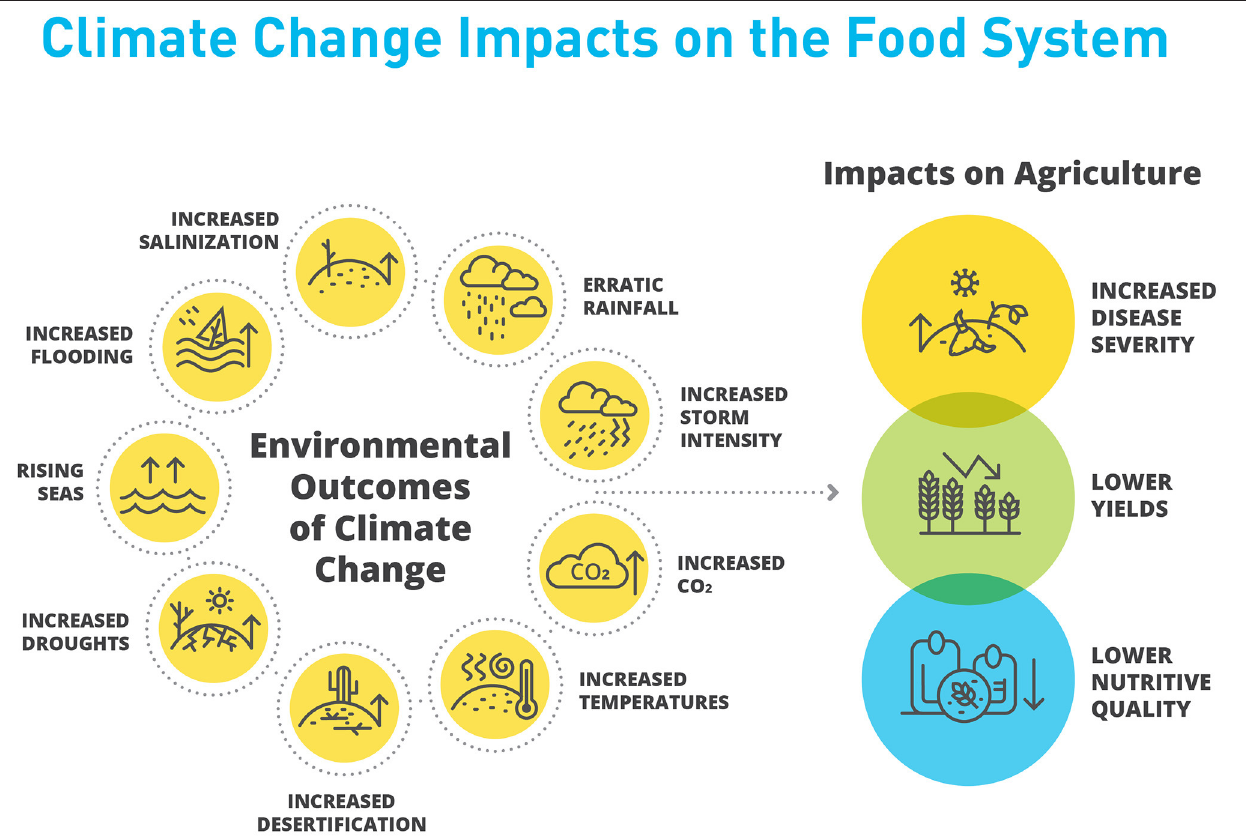
FIGURE 1 | Climate change will negatively impact food